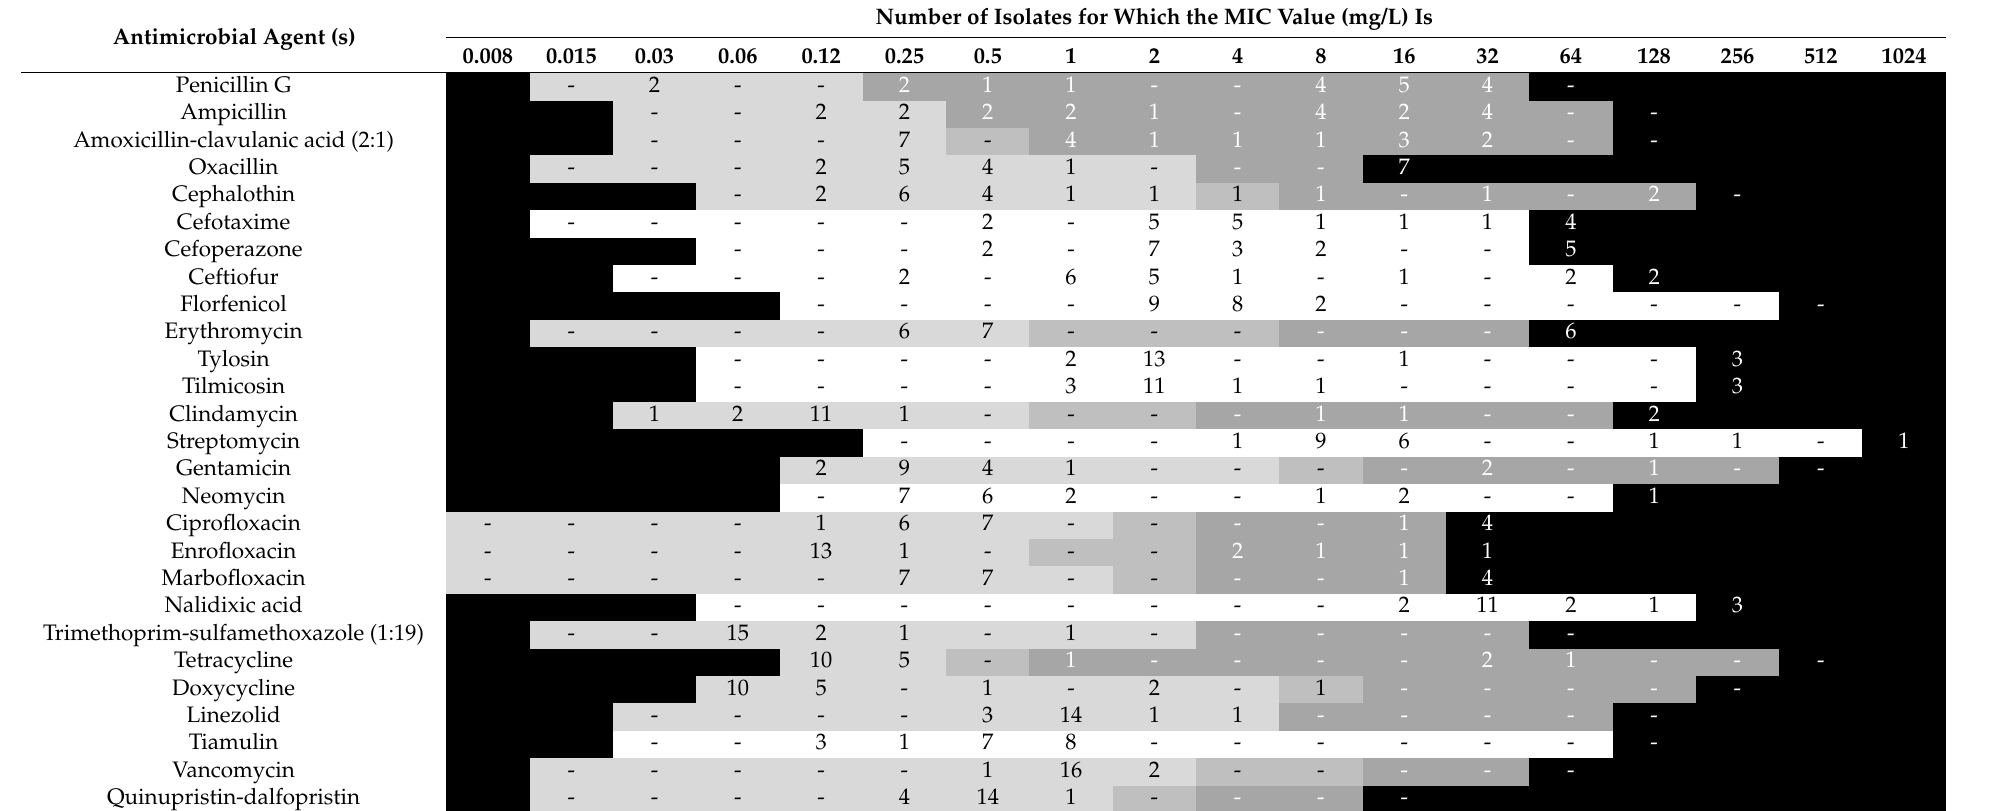
Table 2. Minimal inhibitory concentrations of the 19 canine S. aureus